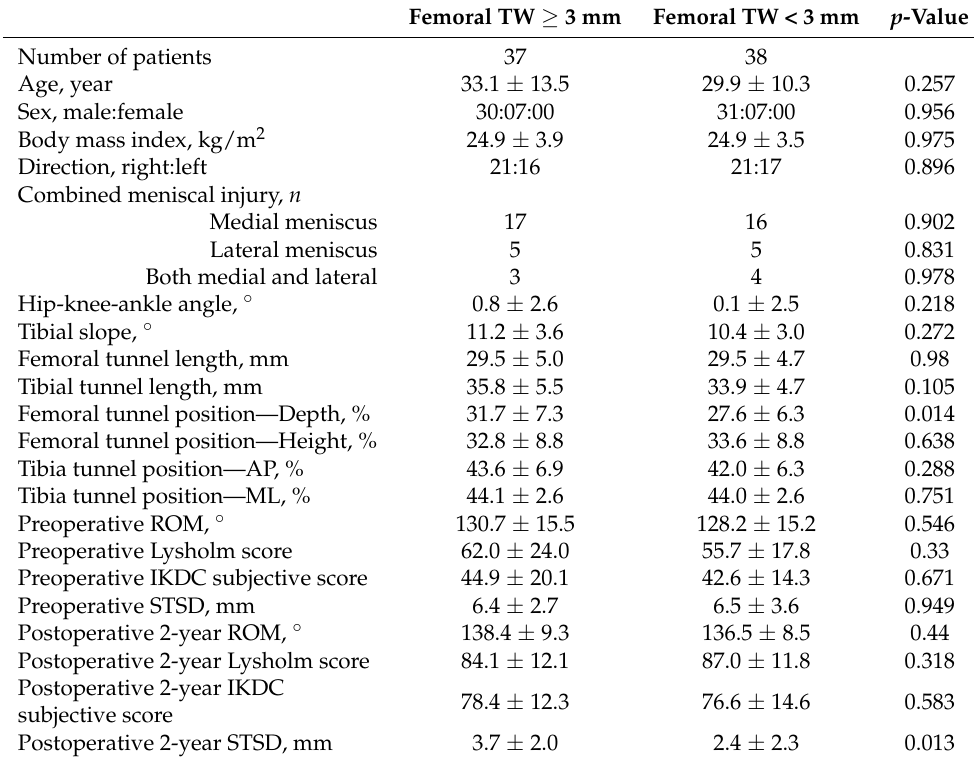
Table 4. Comparison of preoperative, immediate and postoperative outcomes between femoral tunnel widening ≥ 3 mm group and <3 mm group.